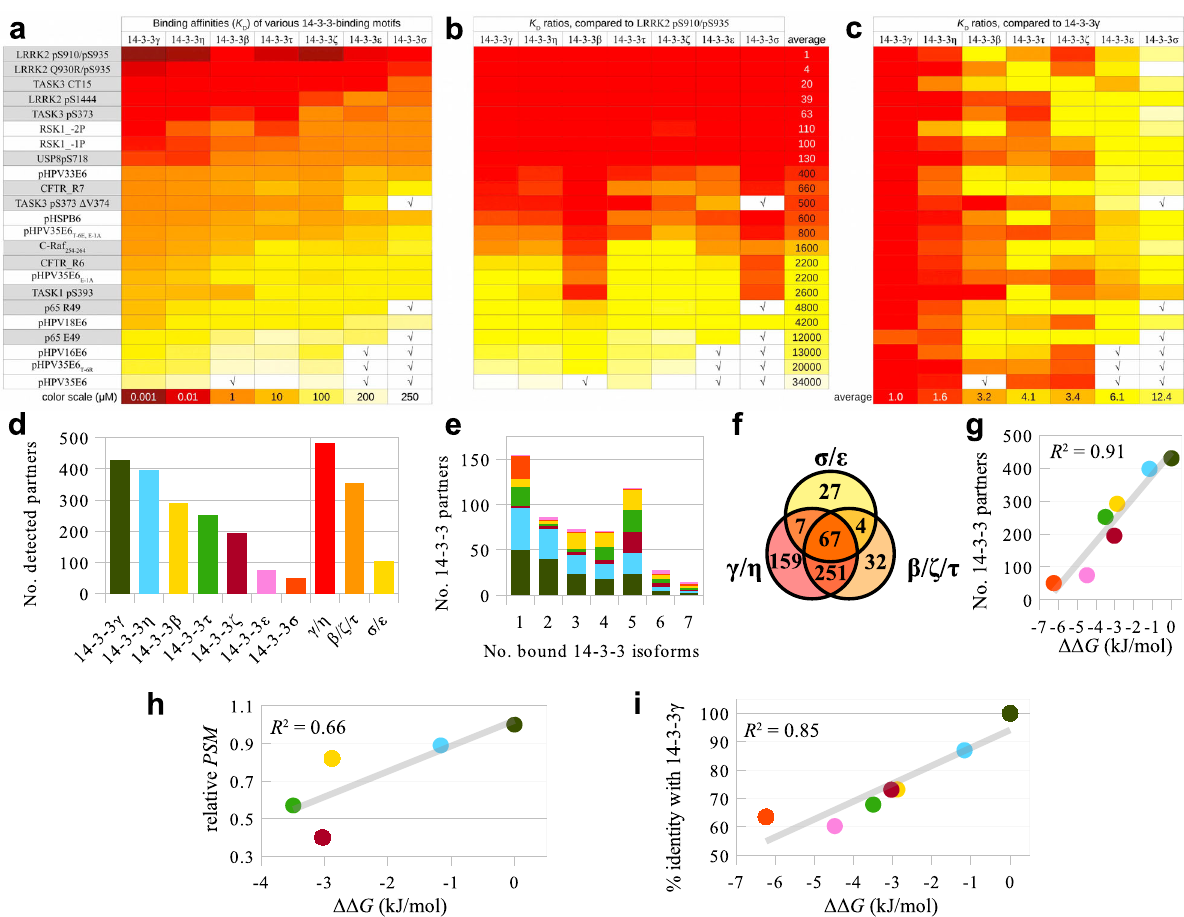
Fig. 4 Hierarchized target binding by 14-3-3 isoforms is a general trend. a Af fi nity maps of 14-3-3 interactions based on experimentally determined dissociation constants against the 14-3-3ome, as obtained in this study (white background) and in others 40,44 – 48 (gray background). The color scale is either based on af fi nity values or on K D ratios. √ denotes af fi nities weaker than the limit of quantitation of the experimental assays. b Same map as in a , normalized to the strongest 14-3-3-binding motif. An average 34,000-fold K D ratio is observed between the strongest and weakest 14-3-3-binding peptide. c Same map as in a , normalized to the strongest phosphopeptide-binding 14-3-3 isoform. Note that all peptides follow very similar af fi nity trends between the different 14-3-3 isoforms, with an average 12-fold K D ratio between the strongest and weakest-binding 14-3-3 isoform. d Number of unique partners detected according to the BioPlex database 29 for each 14-3-3 isoform, taken individually (left) or grouped in three subsets (right) following their relative af fi nity trends (strong, intermediate, and weak binders). e Number of 14-3-3 partners in BioPlex, which bound to 1, 2, 3, 4, 5, 6, or all 7 isoforms, respectively. Within each bar, the proportion of partners that bound to each individual isoform is indicated (same isoform color code as in d ). f Venn diagram showing repartition of the 14-3-3 partners from BioPlex among the strong, medium, and weak phosphopeptide-binding subsets, de fi ned as in d . g Correlation between the number of binders of 14-3-3 isoforms, according to BioPlex, and ΔΔ G av between the strongest phosphopeptide-binder, 14-3-3 γ , and all individual isoforms (same color code as in d ). ΔΔ G values were calculated from the average K D ratios from c . h The average amounts of prey proteins from BioPlex (normalized to the amount captured using 14-3-3 γ ) that interact with at least fi ve different 14-3-3 baits, deduced from their PSM values, also show a correlation with the ΔΔ G av values of the same proteins. i Correlation of the sequence identity of human 14-3-3 isoforms relative to 14-3-3 γ with the ΔΔ G av values from g . Source data are provided as a Source Data fi